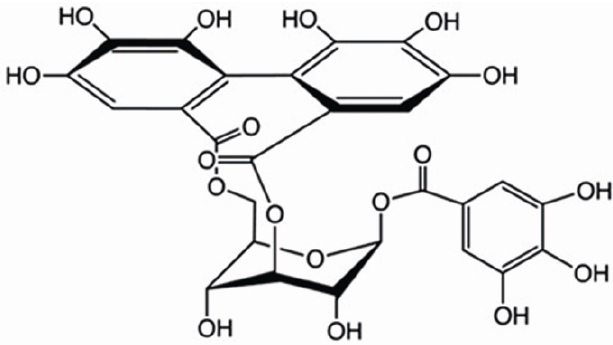
H O ). Its molecular weight is 27 22 18